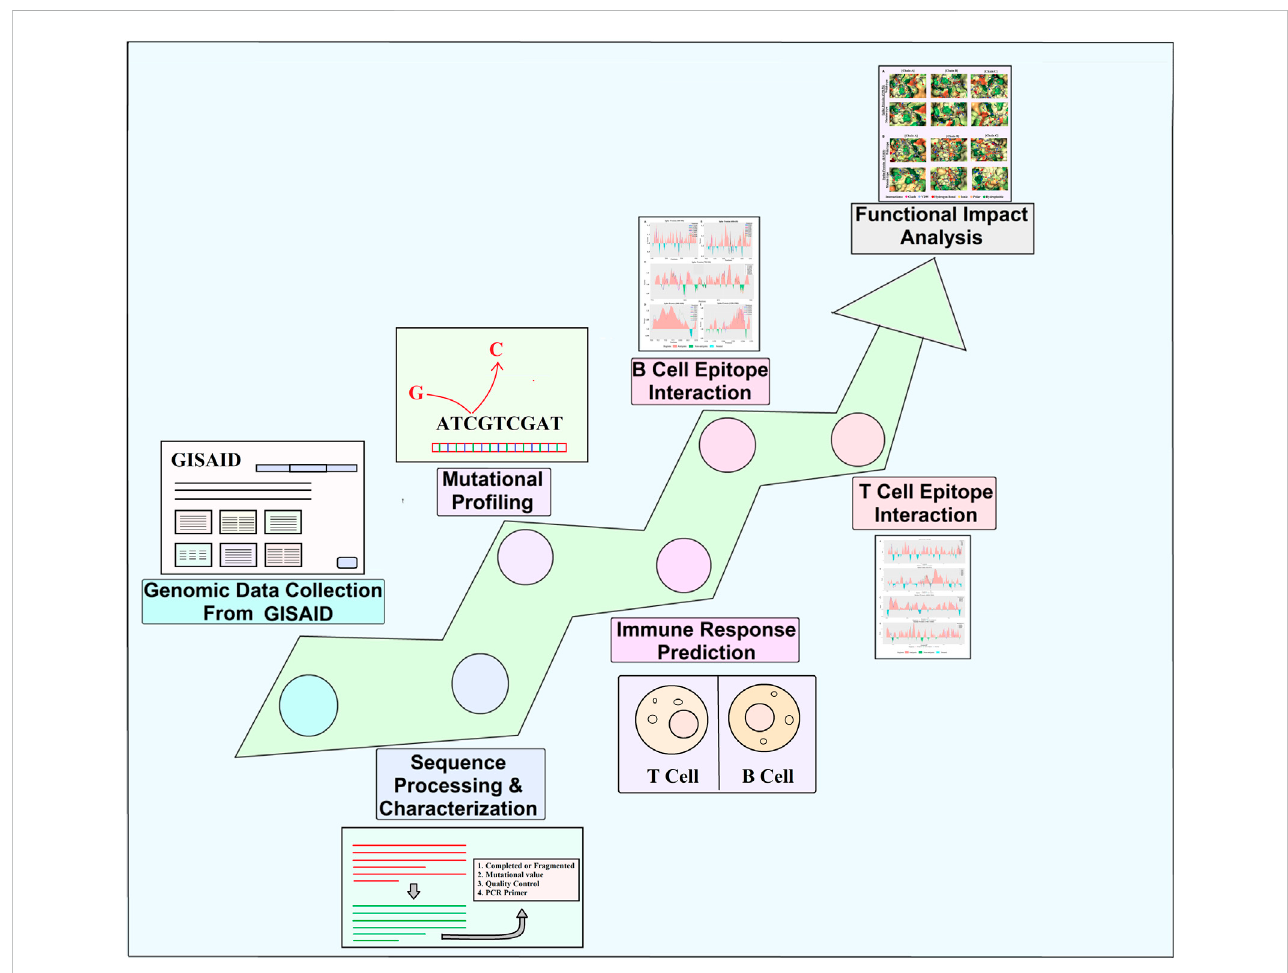
FIGURE 1 Schematic diagram representing several stages starting from genomic data collection to